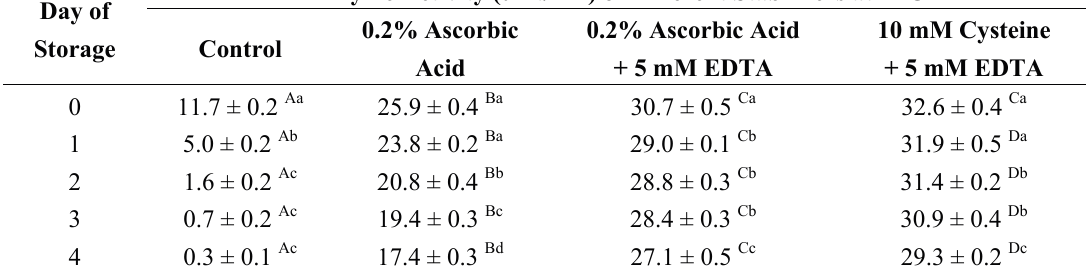
Table 1. Effect of extraction stabilizers on activity of Bentong ginger protease. Means in the same row with the same superscript capital letter are not significantly different ( p ≤ 0.05). Means in the same column with the same superscript small letter are not significantly different ( p ≤